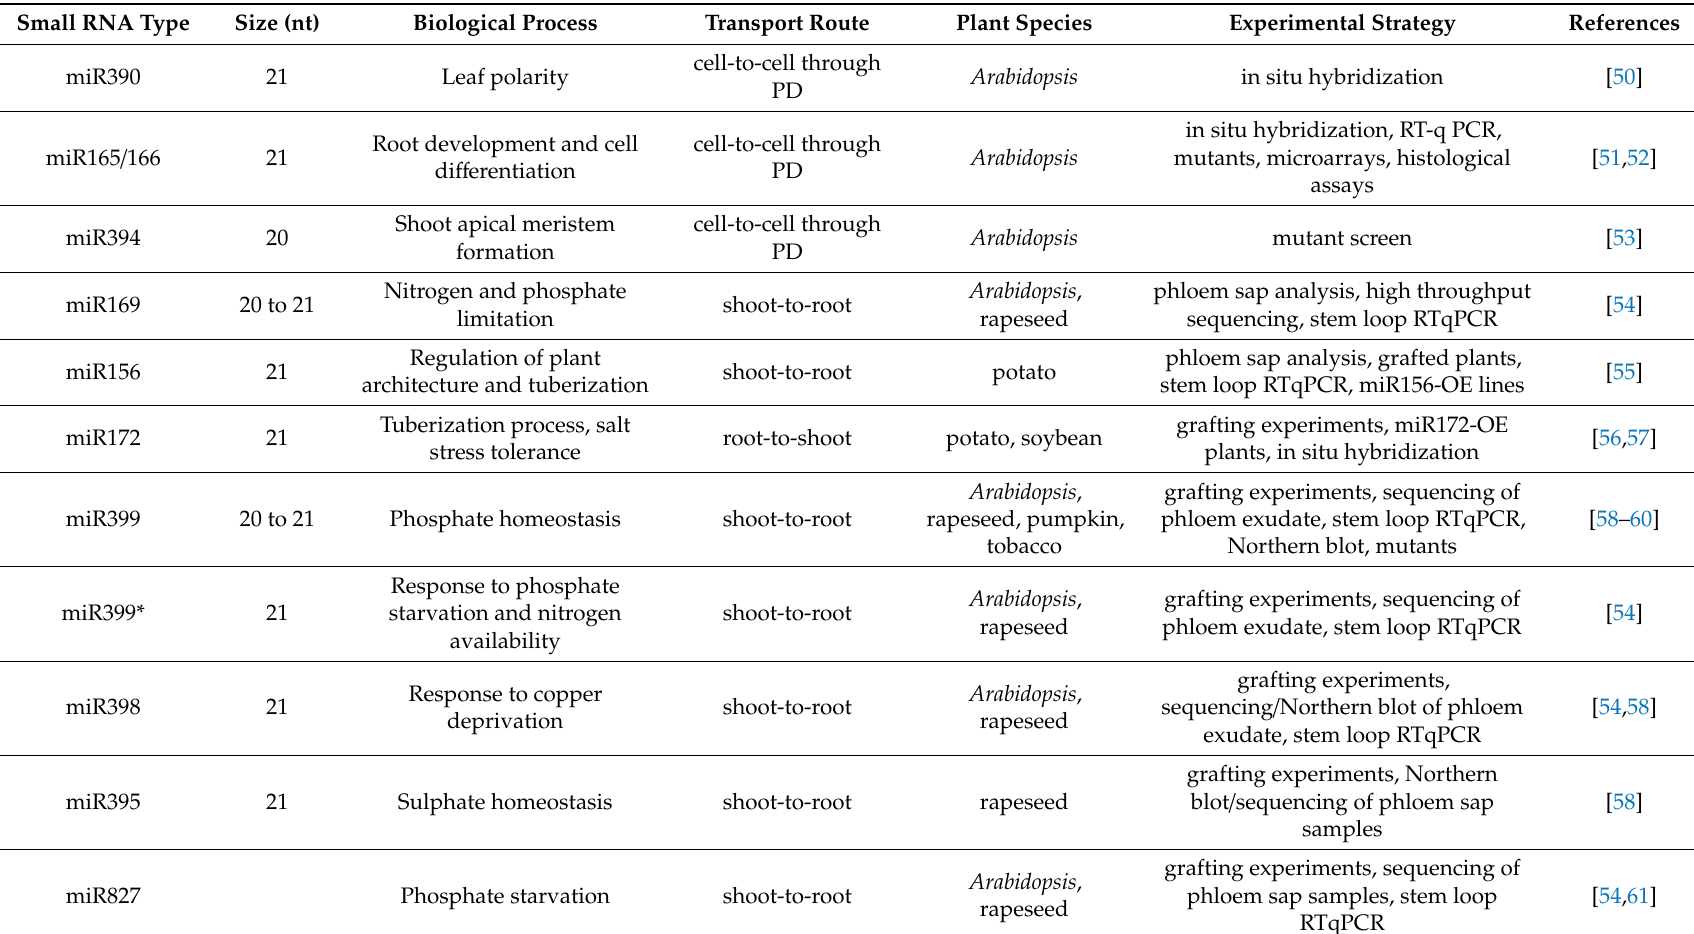
Table 1. Summary of mobile endogenous small RNAs identified in plants so far. PD: plasmodesmata; OE: over-expressing; TE: transposable elements; RT-qPCR: real-time quantitative polymerase chain